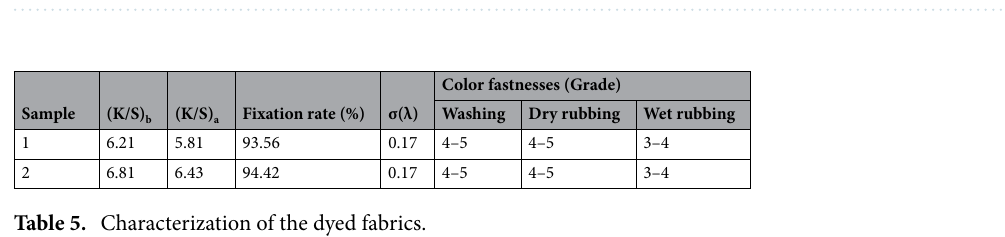
Figure 9. The main effects plot for each factor with their mean S/N ratios.